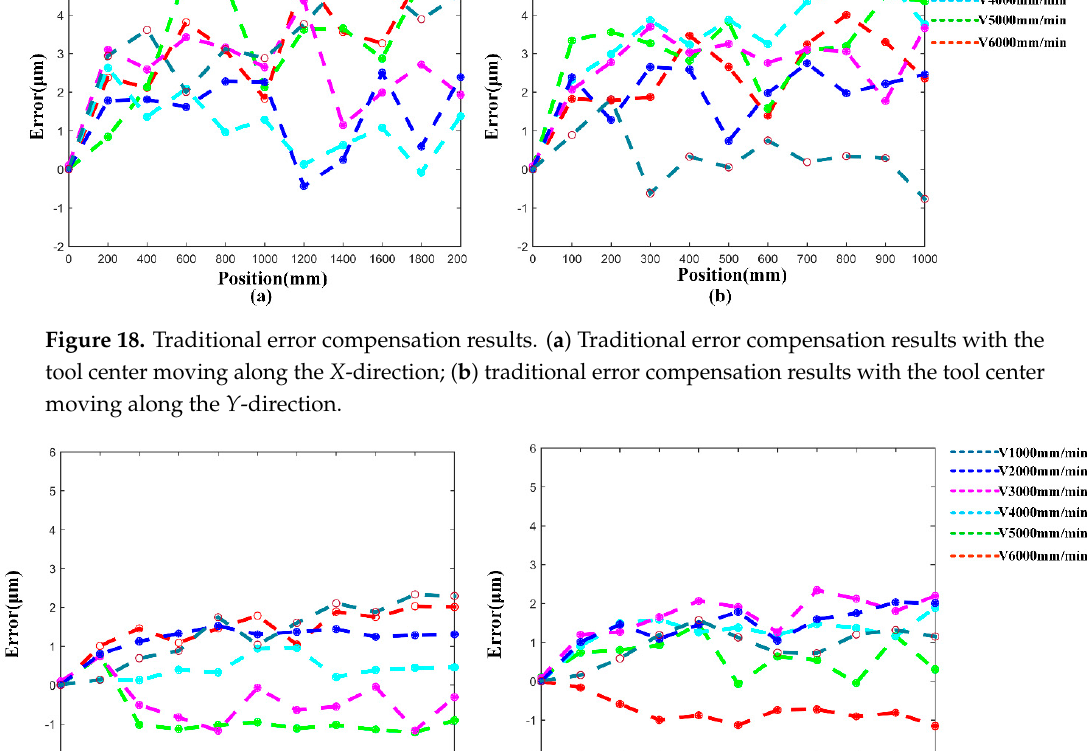
Figure 19. Non-delay error compensation results. ( a ) Non-delay error compensation results with the tool center moving along the X -direction; ( b ) non-delay error compensation results with the tool center moving along the Y -direction.